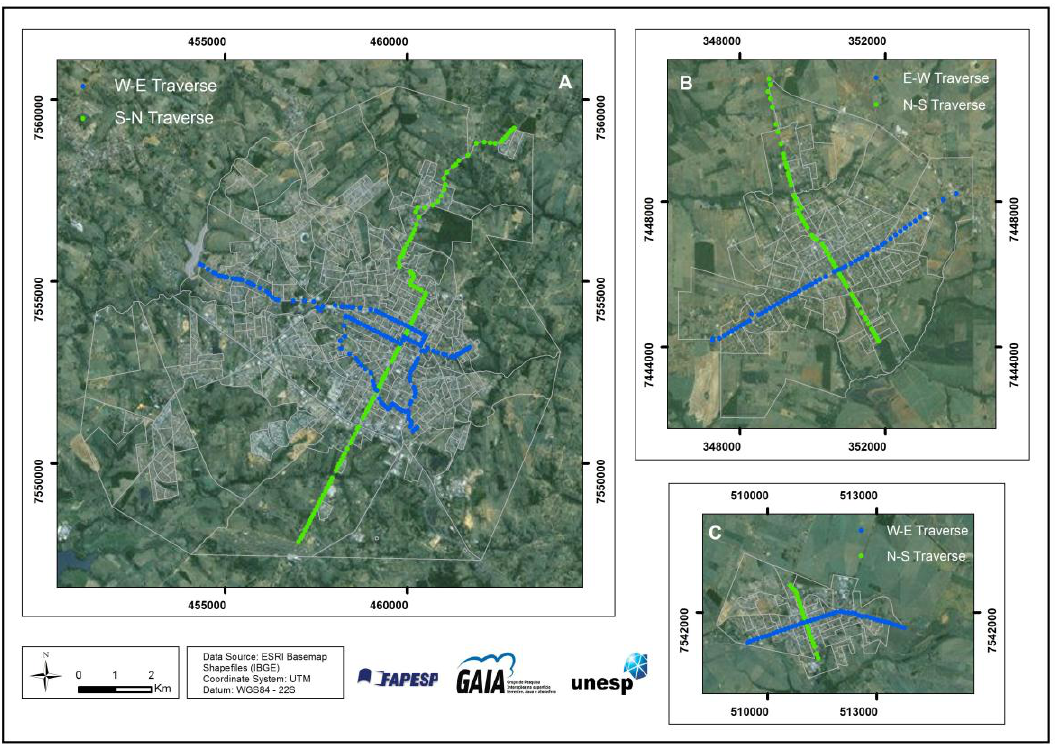
Figure 2. Traverses across ( a ) Presidente Prudente (São Paulo), ( b ) Paranavaí (Paraná), and ( c ) Rancharia (São Paulo).